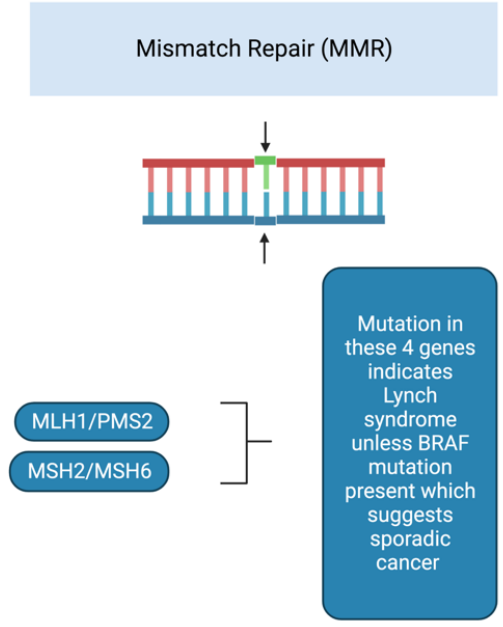
Figure 2. Genes involved in the development of Lynch syndrome. Figure developed using Bioren-